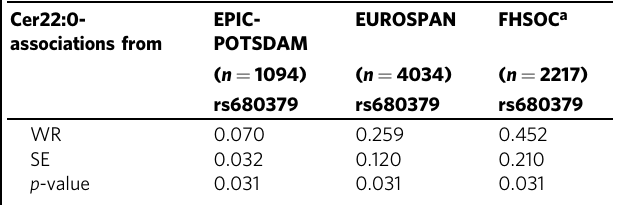
Table 3 Univariable, two-sample Mendelian randomization studies using genetic proxies to estimate effects of Cer22:0 on the risk of T2D. T2D-associations from DIAGRAM ( n = 74,124 T2D cases and 824,006